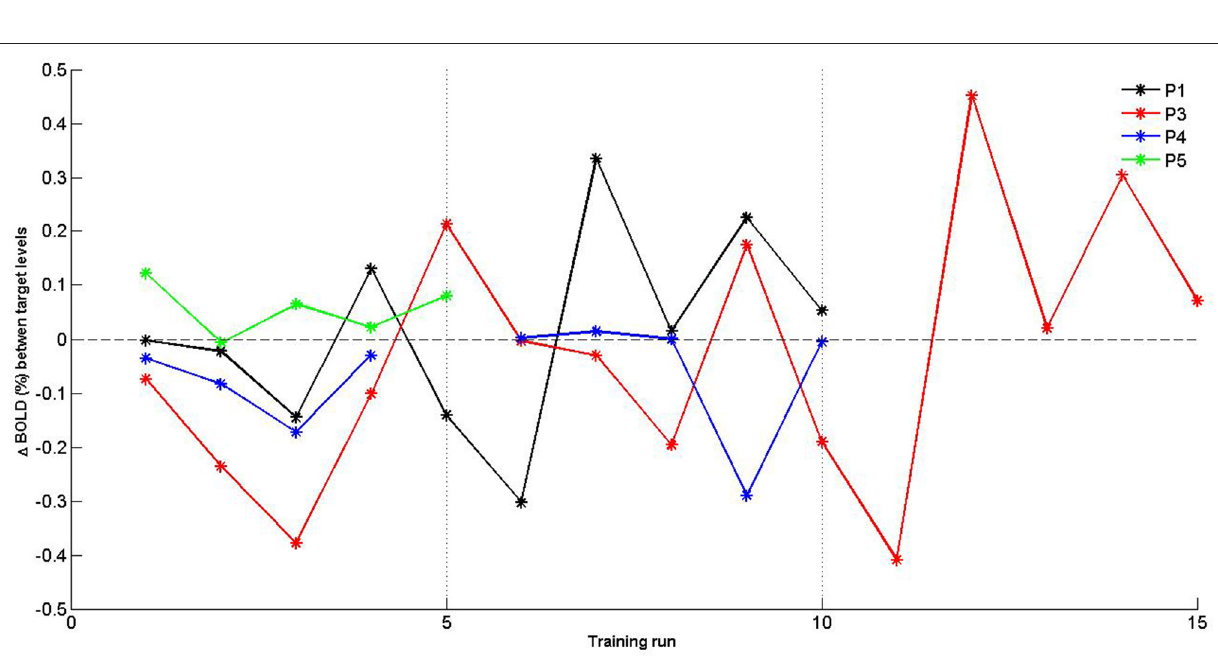
for SMA activation (H1 A ) with patients’ motor impairment scores ( Table 1 ), we found that patients who were the least impaired (P4 and P5) showed the largest SMA